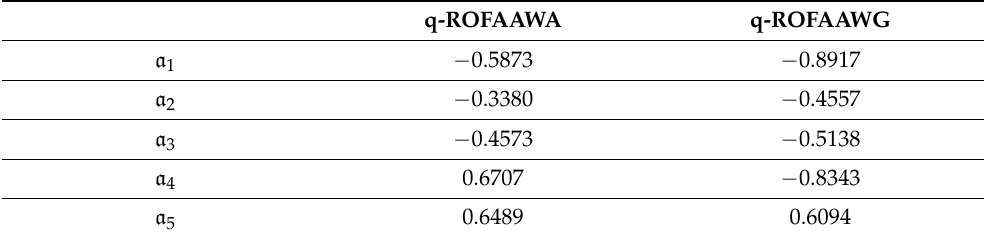
Table 4. Scores of aggregated